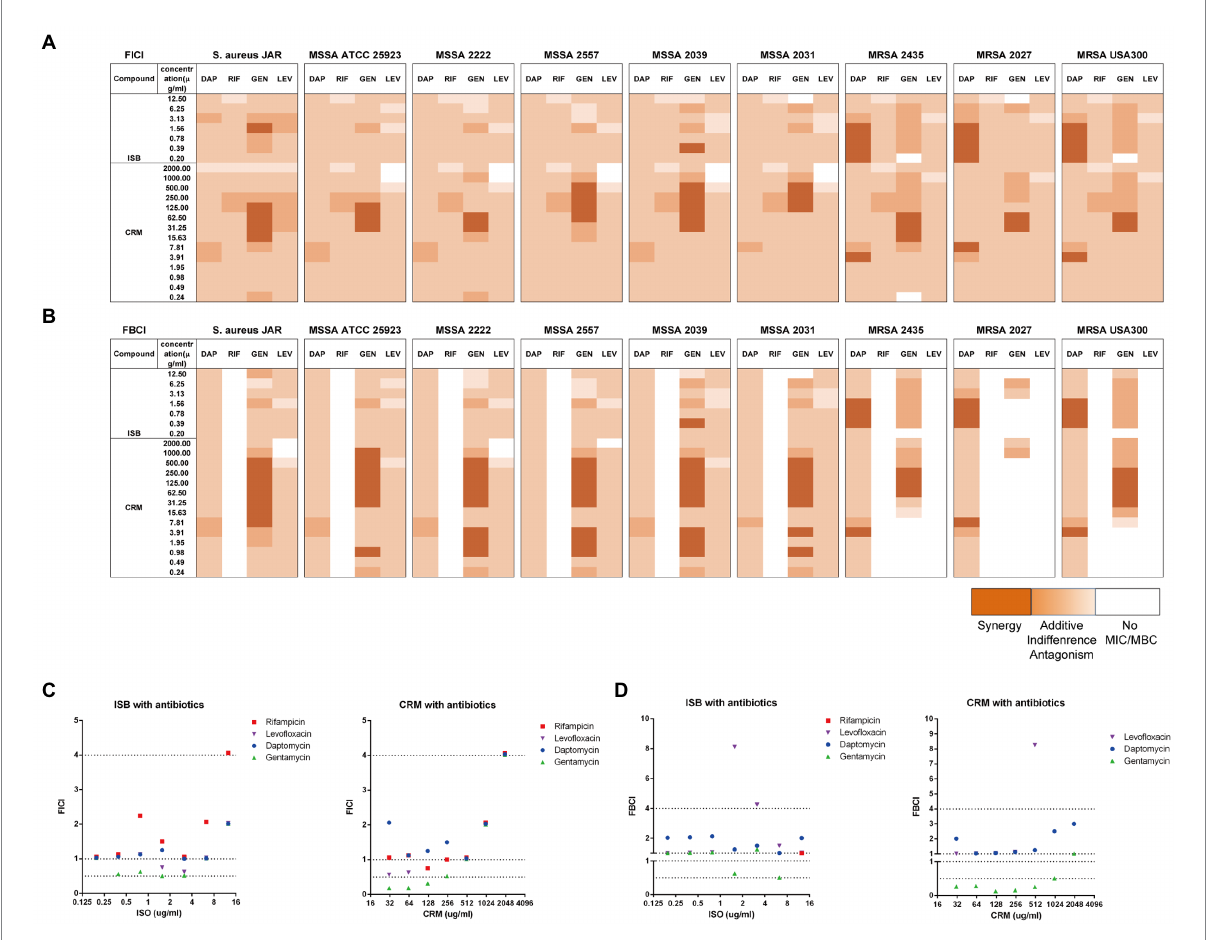
FIGURE 2 Interaction of Isobavachalcone and Curcumin with Antibiotics on MSSA and MRSA strains. (A,B) Heatmaps of fractional inhibitory concentration index (FICI) and fractional bactericidal concentration index (FBCI) of combination of gentamycin with isobavachalcone or curcumin, darker orange color indicates interaction is superimposed or synergistic. (C,D) FICI and FBCI of Isobavachalcone and Curcumin with antibiotics against Staphylococcus aureus JAR strain, respectively. FICI ≤ 0.5 represents synergy, FICI > 0.5–4 represents no synergistic interaction, and FICI > 4.0 represents antagonism. FICI: fractional inhibition concentration index; FBCI: fractional bactericidal concentration index; DAP: Daptomycin with 50 μ g/ml Ca2+; RIF: Rifampicin; GEN: Gentamycin; LEV: Levofloxacin; ISB: Isobavachalcone; CRM: Curcumin; MSSA: Methicillin-susceptible Staphylococcus aureus ; MRSA: Methicillin-resistant Staphylococcus aureus